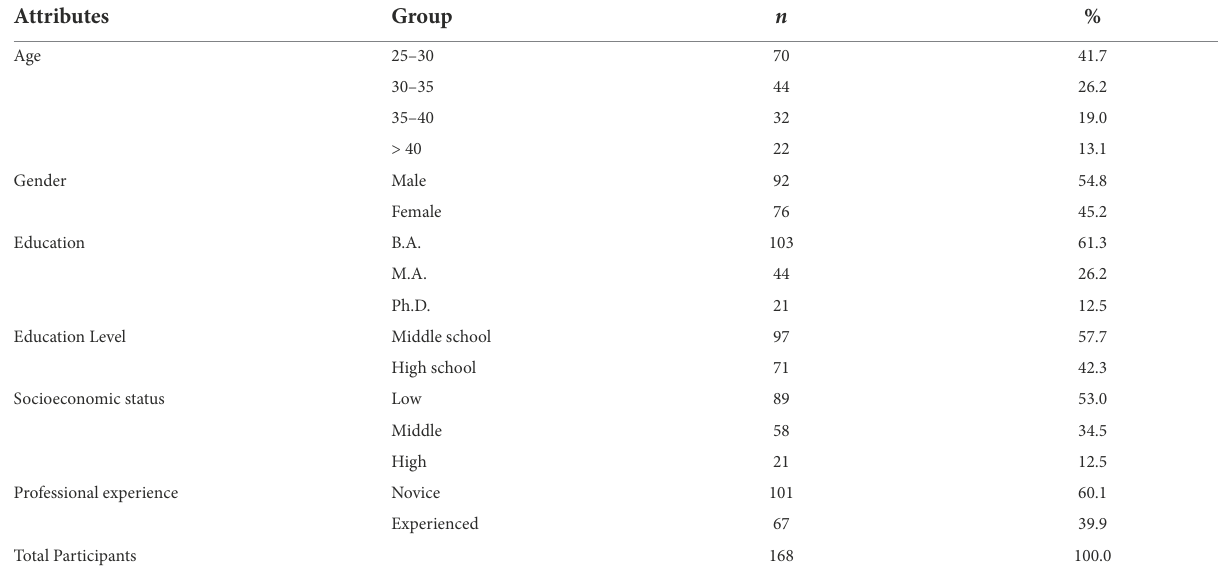
TABLE 1 Teachers’ demographic and occupational attributes ( N =